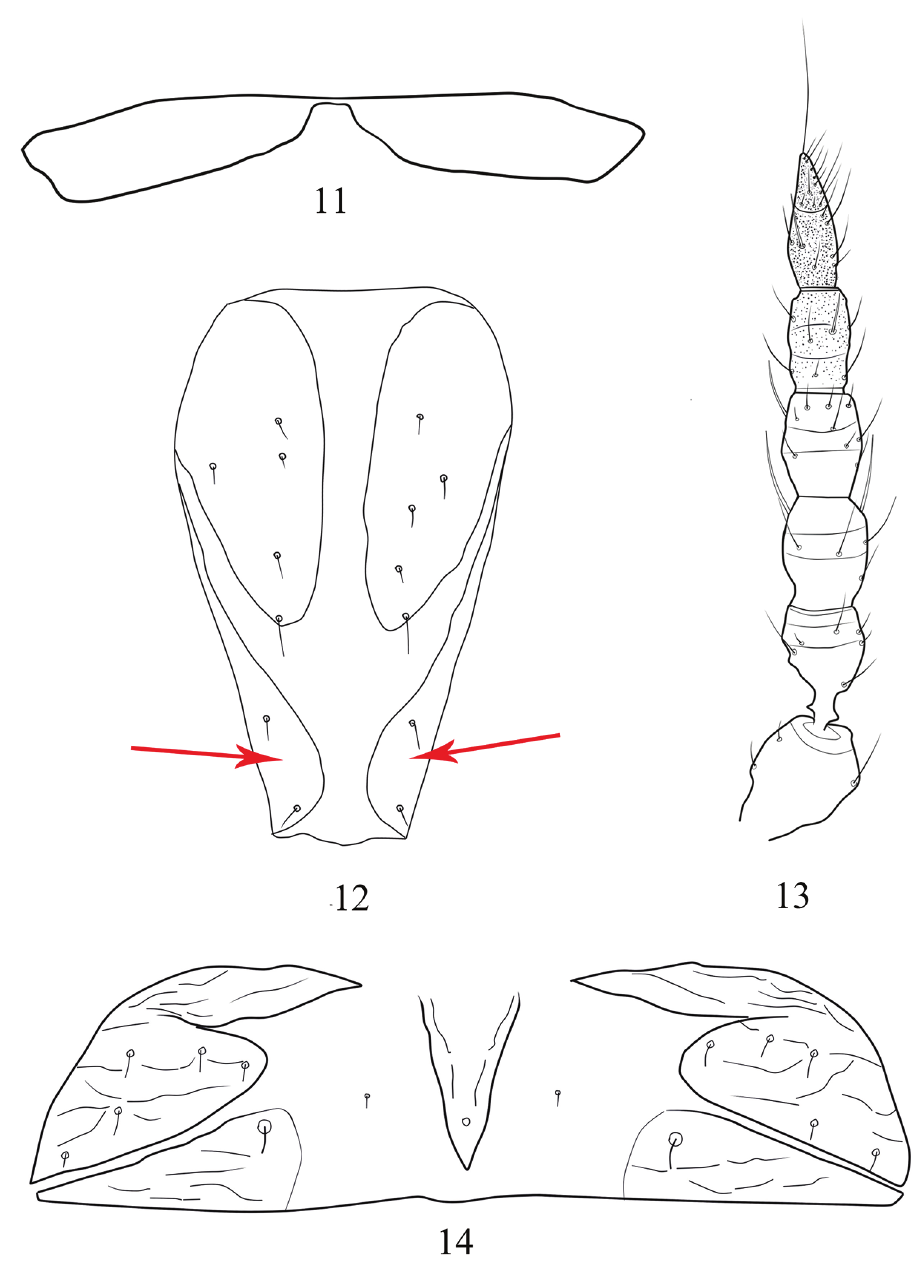
indicates the ovispan) 13 antennal segments II–VIII 14 abdominal tergite